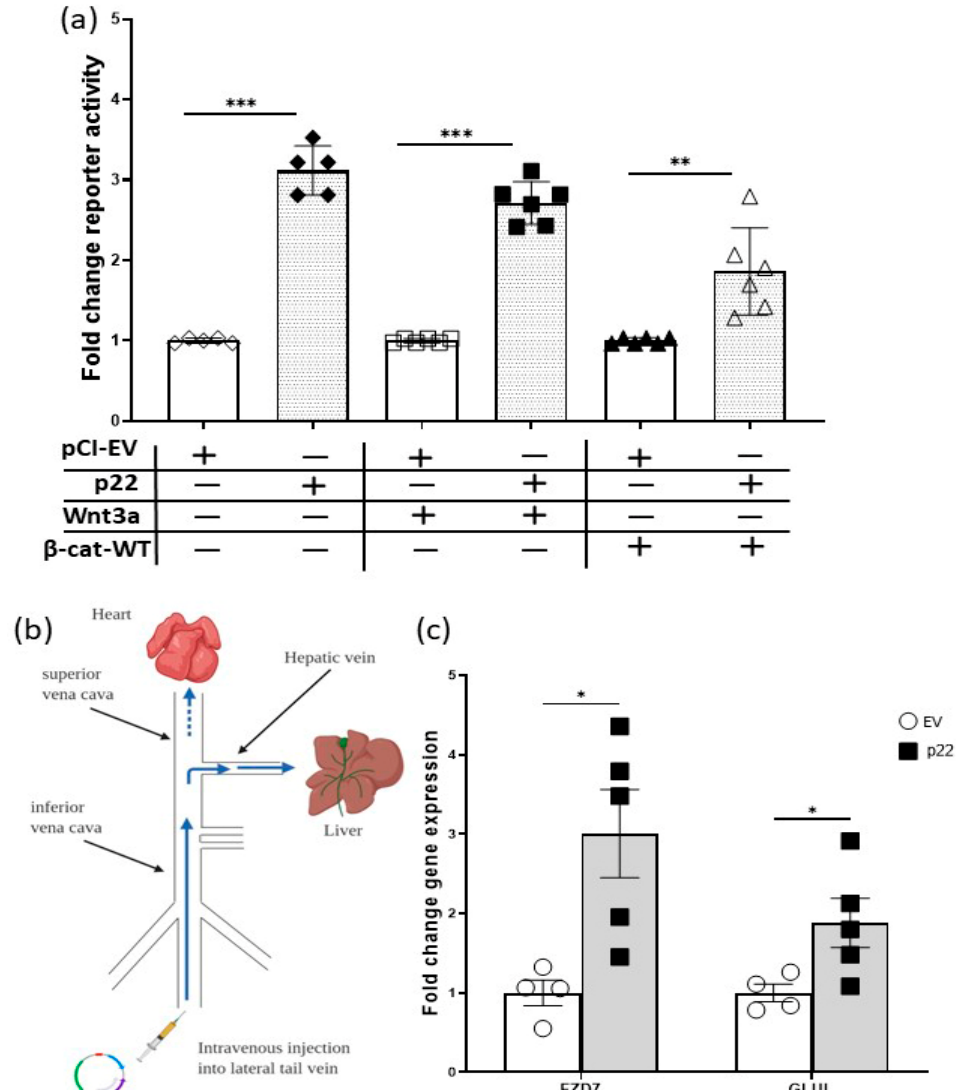
Figure 3. HBV p22 activates TCF / β -target gene native promoters. ( a ) E ff ect of HBV p22 on FZD7-native promoter reporter activity, with and without stimulation with Wnt3a or 100 ng wild-type β -catenin ( β -cat-WT), in Huh7 cells was determined by luciferase activity (pFz7-prom reporter) and is shown as fold change relative to empty vector (EV) (mean ± SEM, * p < 0.05, *** p < 0.0001 Student t -test, n = 6 independent experiments). ( b ) Schematic diagram of hydrodynamic tail-vein injection in mice (adapted from [31]). ( c ) Expression of TCF/ β -target genes Fzd7 and glutamine synthase (Glul) was increased in mouse livers 20 days post HDI injection of p22. Gene expression was determined by qRT-PCR and is shown relative to empty vector (EV) (mean ± SEM, * p < 0.05 Student t -test, n ≥ 4 mice).